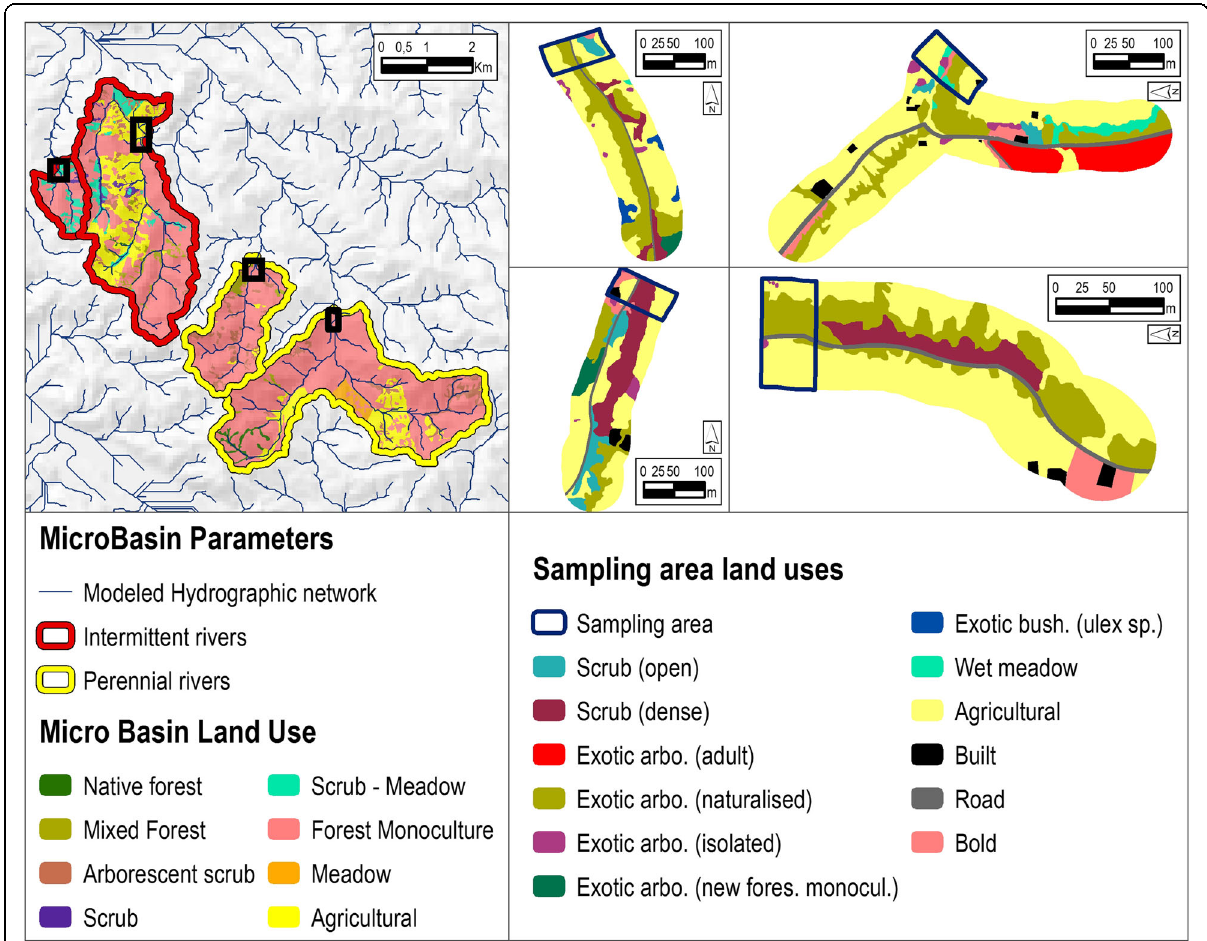
Fig. 2 Soil uses of the microbasins and photointerpretation of the sampled reaches and its influence area